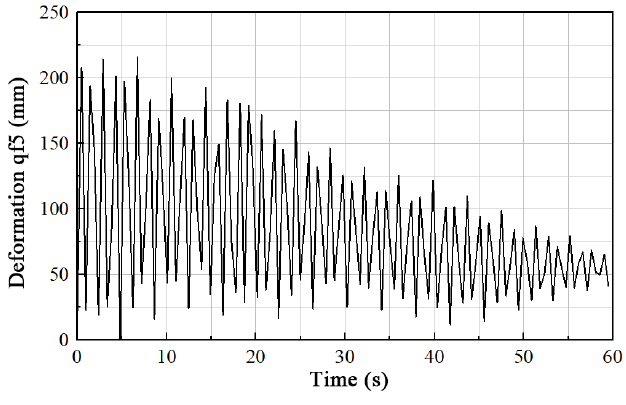
Figure 8. Lateral 1/4 Circumferential Deformation of the Top Node (Group #2) .